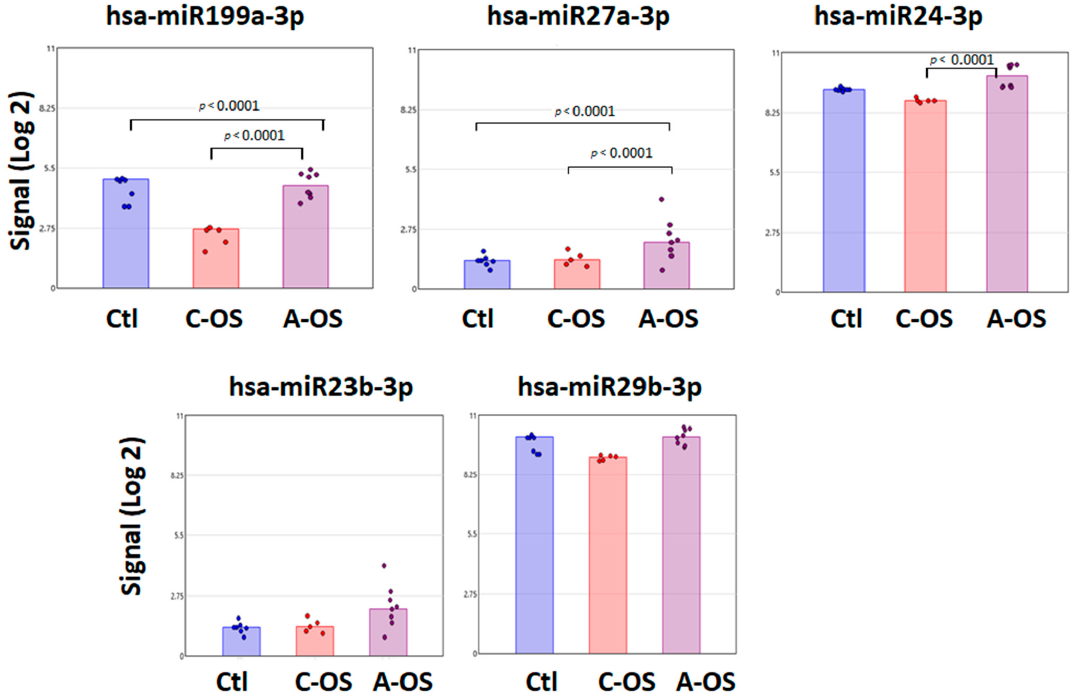
Figure 3. Individual changes in expression of exosomal miRNAs predicted to target GSK . Bar plots depict the Affymetrix signal of hsa-miR199a-3p, hsa-miR27a-3p, hsa-miR24-3p, hsa-miR23b-3p, and hsa-miR29b-3p in NPCE cells-derived exosome following C-OS or A-OS. Each group contains a minimum of five independent replicates. One-way ANOVA was performed to identify the p < 0.001 among these three groups .